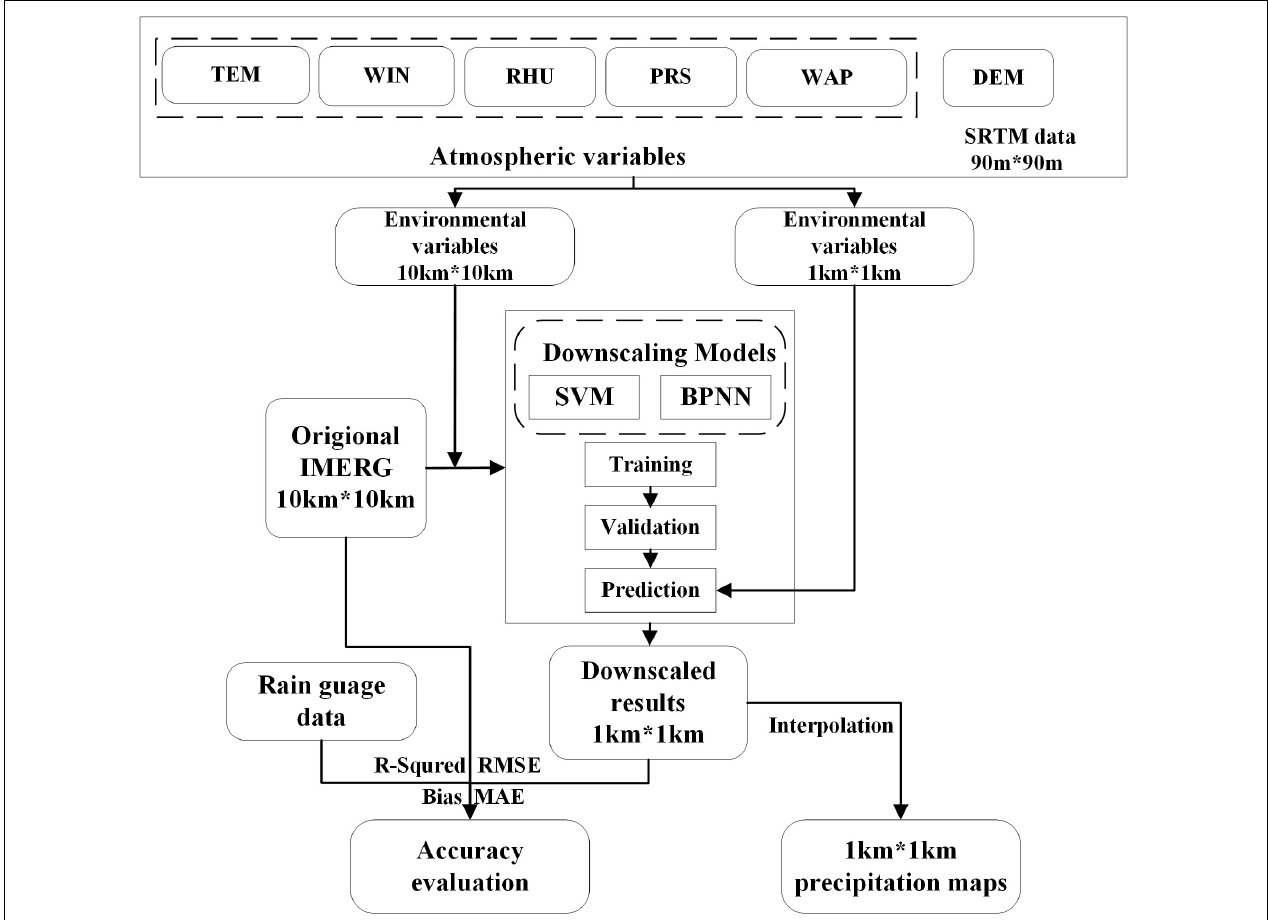
FIGURE 3 | Flowchart of downscaling the original IMERG at daily scale.